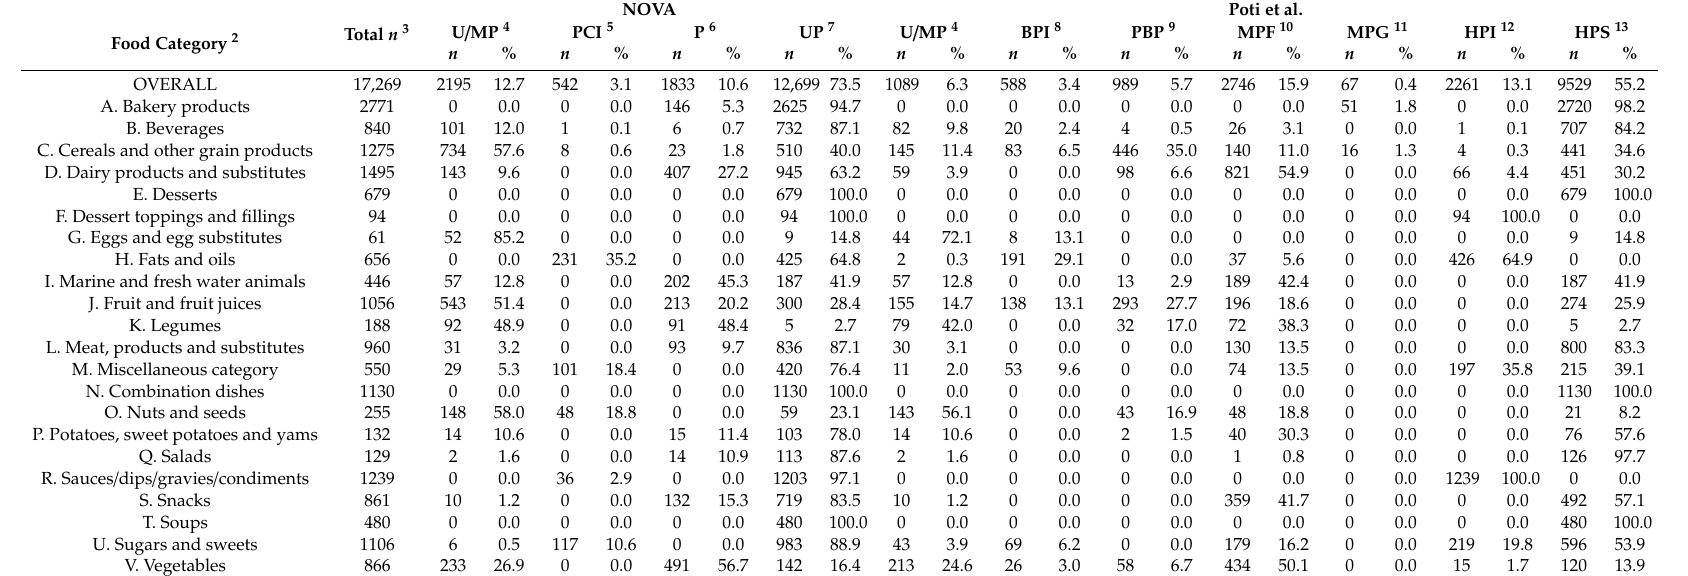
Table 1. The number and proportion of packaged food and beverage products in each category of the NOVA and Poti et al. food processing classification systems 1 , overall and by food